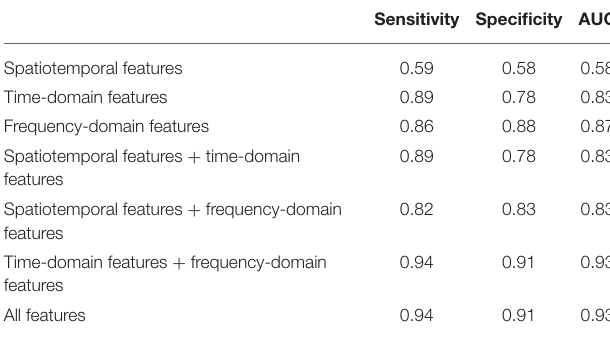
TABLE 6 | Depression recognition performance measures from 10-fold cross